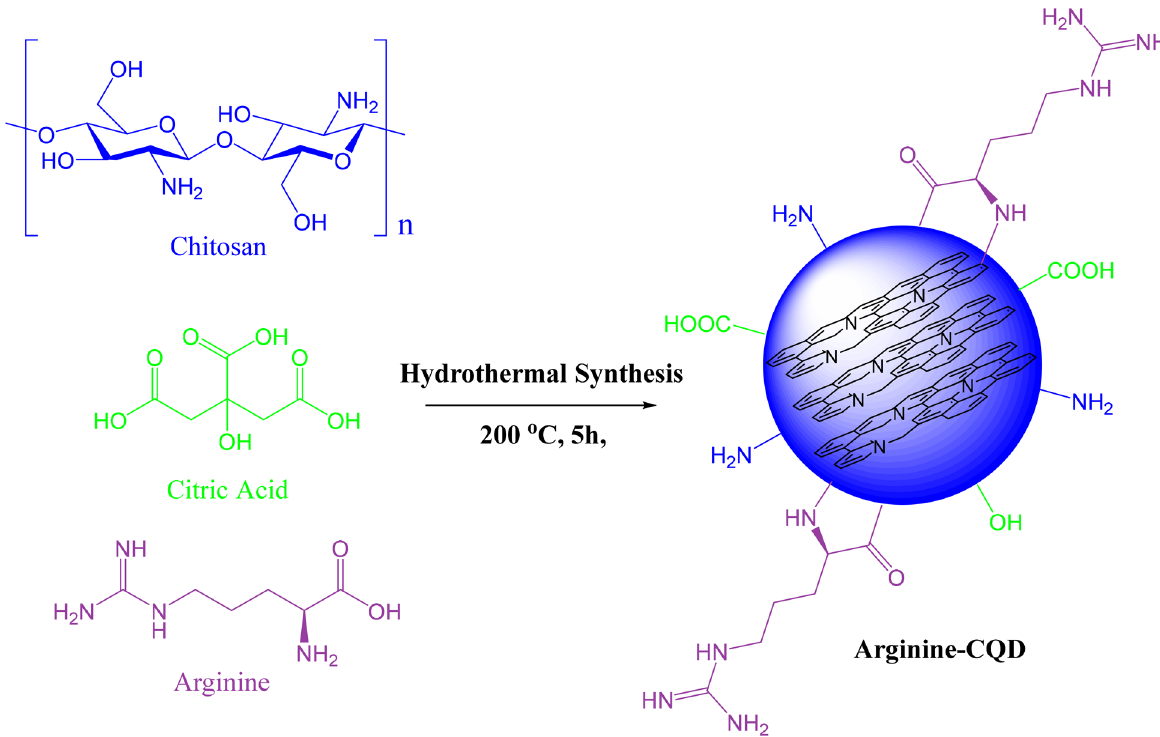
Figure 1. Schematic procedure for the synthesis of the